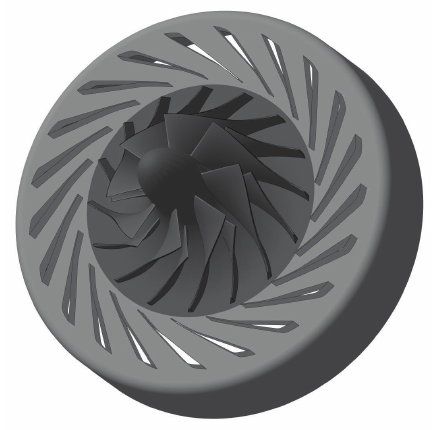
Figure 1: 3D sketch of the compressor stage hub with the return downstream channel.